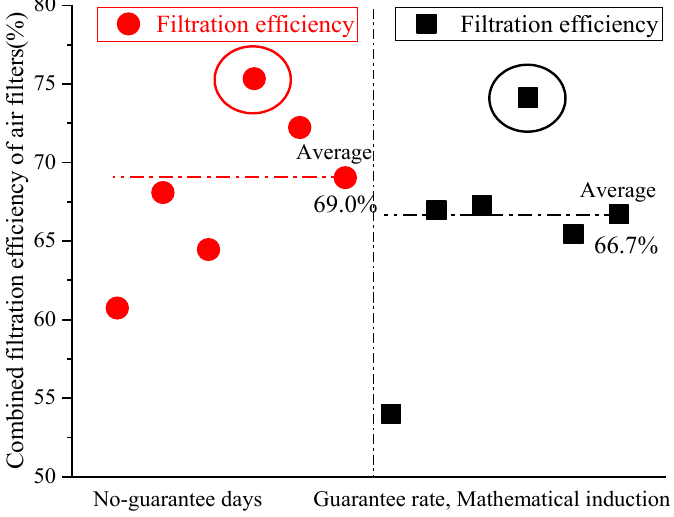
Figure 6. Comparison of outdoor PM 2.5 concentration determination methods for fresh-air filtration.